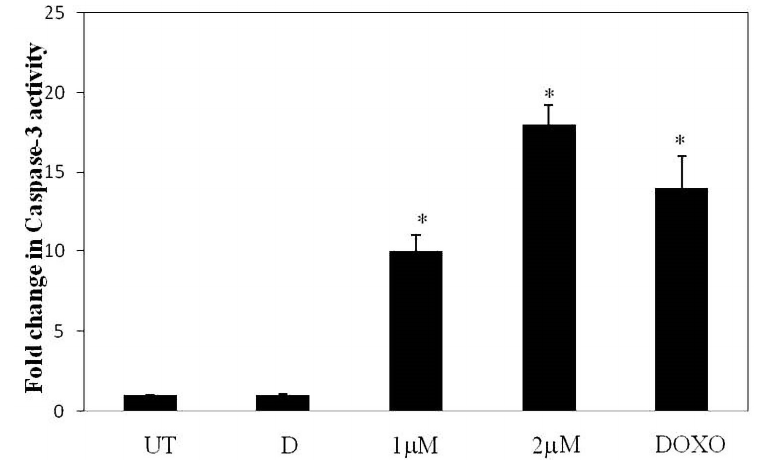
Figure 10. Caspase-3 assay of barbatic acid ( 21 ). A549 cells were seeded and treated with 1 and 2 µM of 21 . Subsequently, the cells were harvested, and lysates were subjected to cellular caspase 3 analysis. As a positive control doxorubicin was employed. UT represents untreated cells and D is DMSO, vehicle control. Values are mean ± SD, the assay was repeated two times in triplicates ( n = 6). * p < 0.05 vs. control is treated as statistically